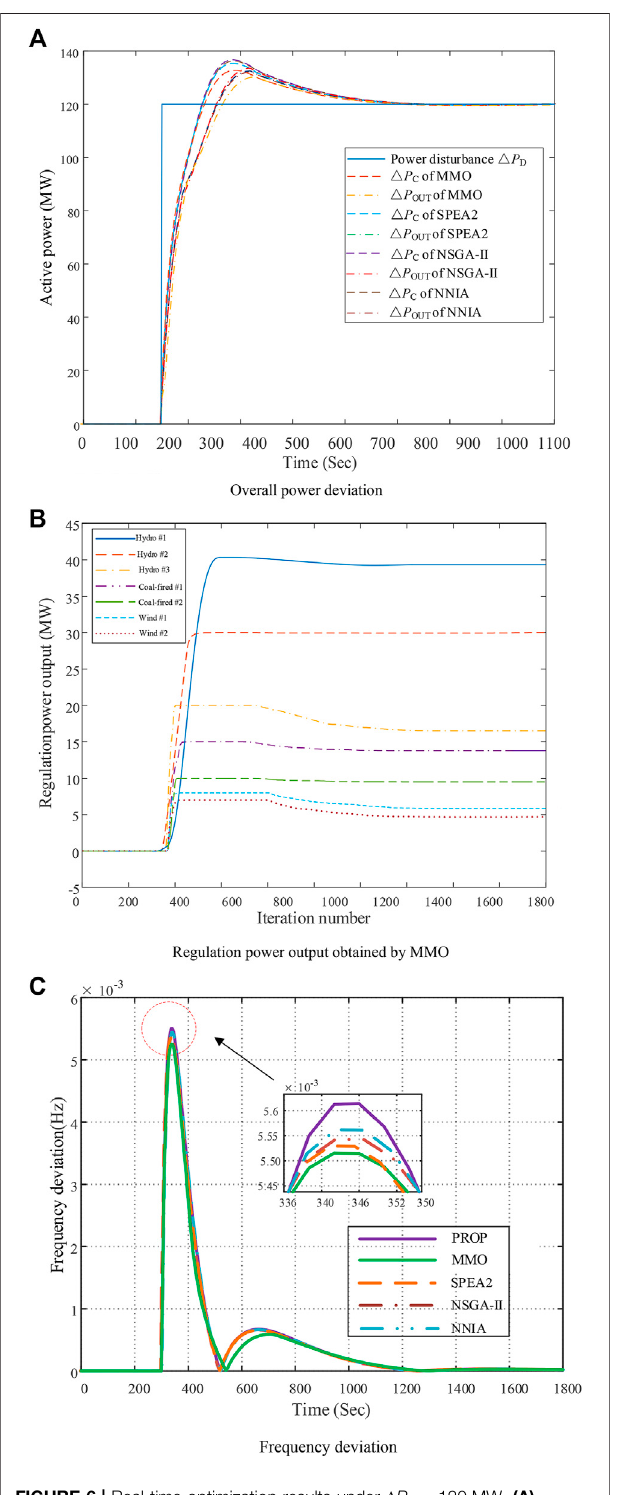
FIGURE 6 | Real-time optimization results under Δ P D = 120 MW. (A) Overall power deviation. (B) Regulation power output obtained by MMO. (C) Frequency deviation.